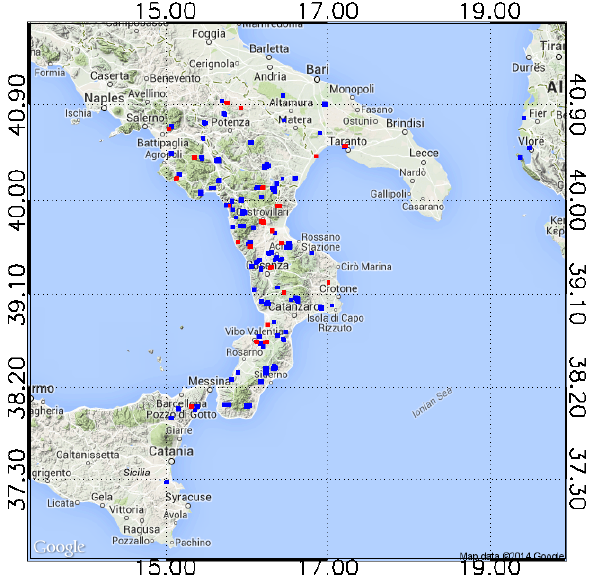
Figure 14. MODIS active fire detections occurring between 27 and 31 August (blue symbols) and 28 and 29 August (red symbols). These fires typically occur downwind of the Algerian smoke plume seen in Fig. 13 and therefore are likely to have contributed to ele- vated AOD values detected at the Lecce AERONET site.